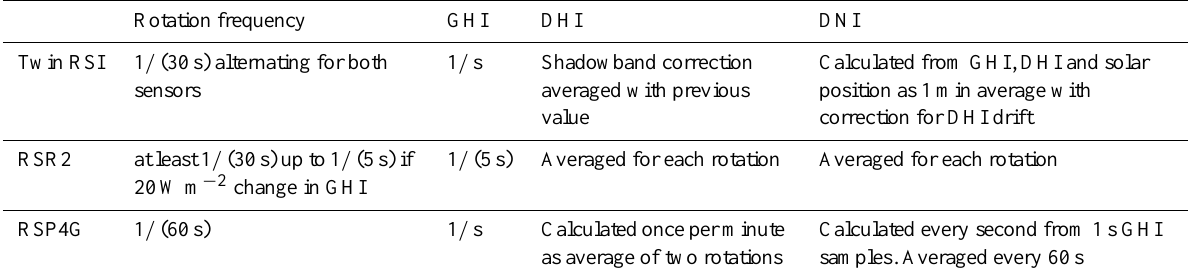
Table 4. Calibration limits (Geuder et al.,